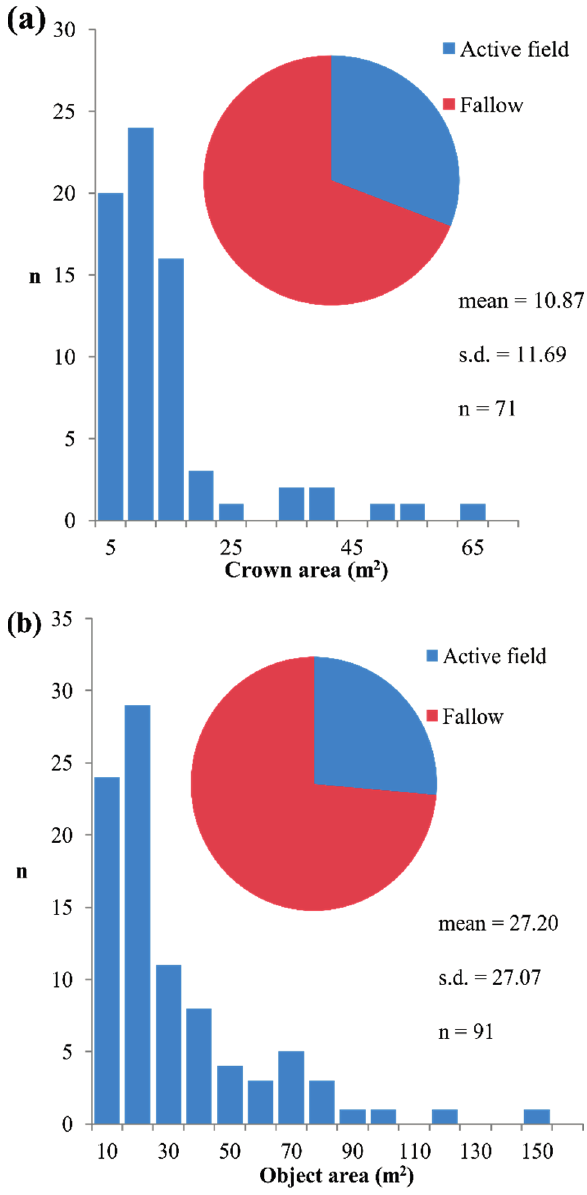
Figure 5. Diagrams presenting statistics for ( a ) omission errors and ( b ) commission errors. The bar-charts show the errors distributed in size classes, whereas the pie-charts show the distribution of errors in the two land-use categories (active field and